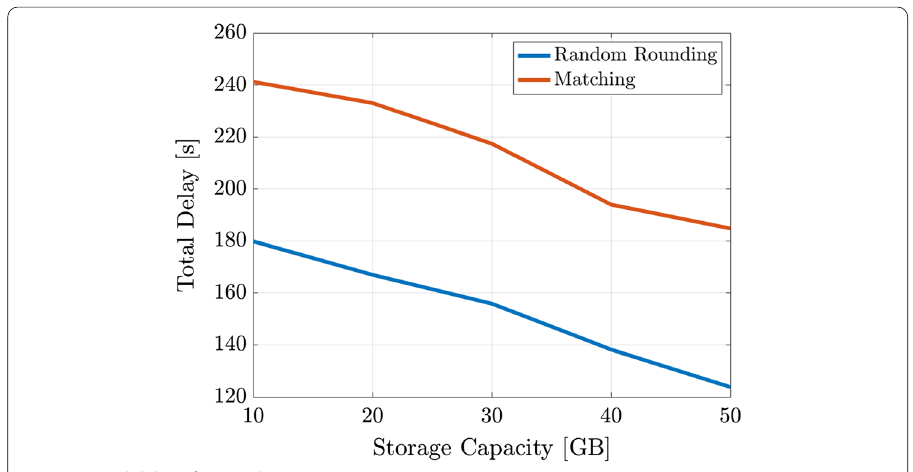
Fig. 16 Total delay of network